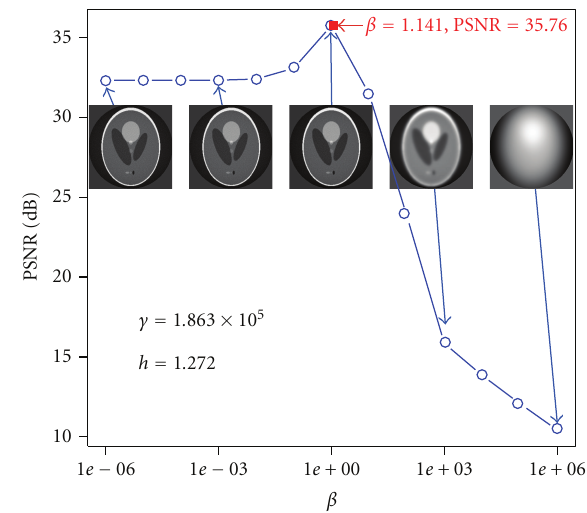
Figure 4: Reconstruction performance against hyperparameter β . The horizontal axis shows the β , and the vertical one shows the PSNR. Other hyperparameters, h and γ , are fixed to the estimated value. The filled rectangle shows the result of our hyperparameter inference for β